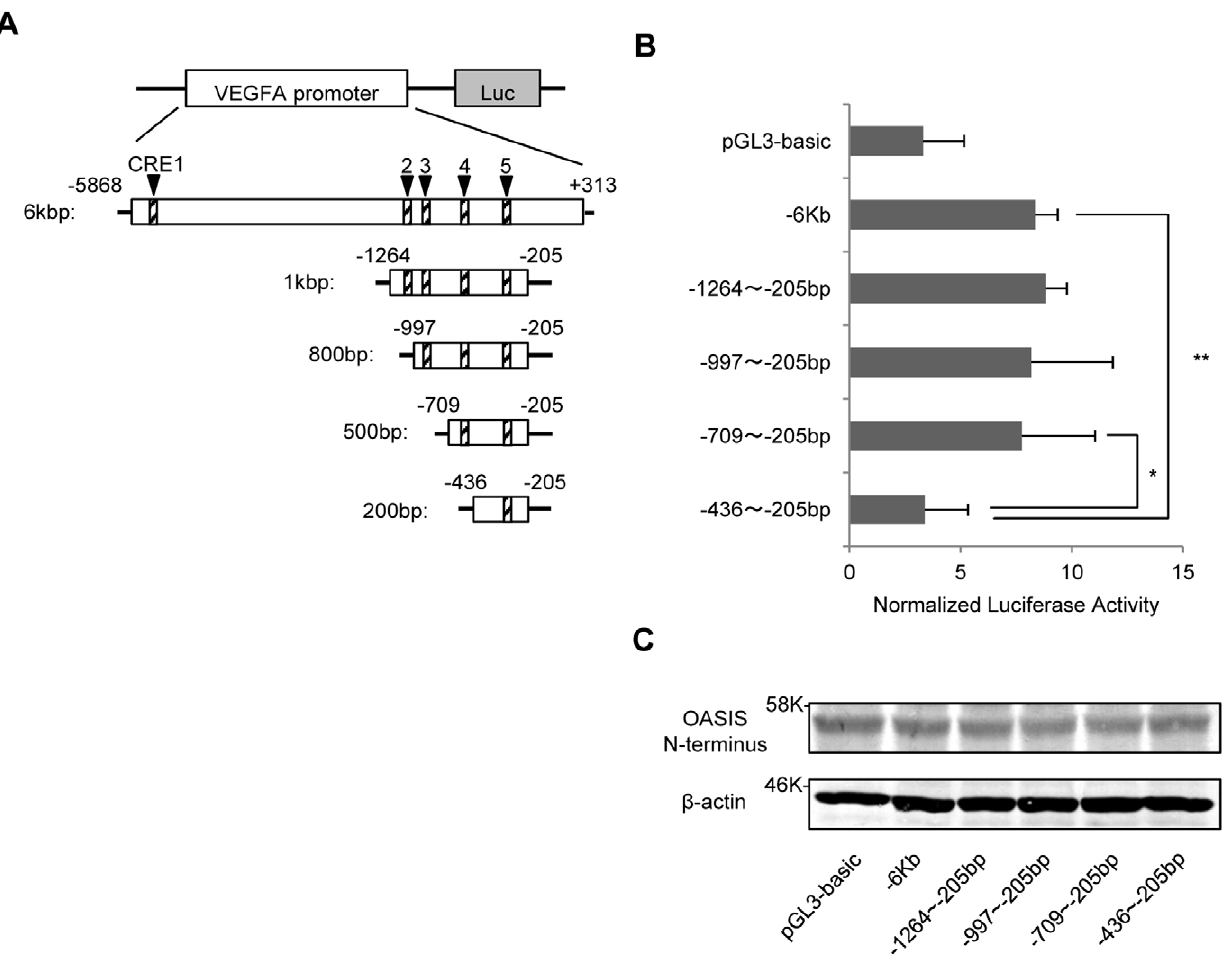
Figure 3. OASIS modulates VEGFA promoter activities via the region between –709 and –437 bp. (A) Schematic diagrams of the deleted reporter constructs from the 6-kbp 5 9 -upstream promoter of the human VEGFA gene. Five putative CRE-like sites (containing an ACGT core) exist in the 6-kbp VEGFA promoter region. (B) Reporter assays using ARPE-19 cells. Each deletion reporter vector and the OASIS N-terminus expression vector were co-transfected. Reporter assays were performed at 48 h after the transfection. Note that reporter activities significantly decreased in cells transfected with the 200-bp construct, suggesting that OASIS acts on a site in the region between –709 and –437 bp of the VEGFA promoter. Data are means 6 SD (n=6). *p , 0.05, **p , 0.01, by Student’s t -test. (C) Western blot analysis shows the FLAG-tagged OASIS N-terminus was expressed at equal levels in each sample.